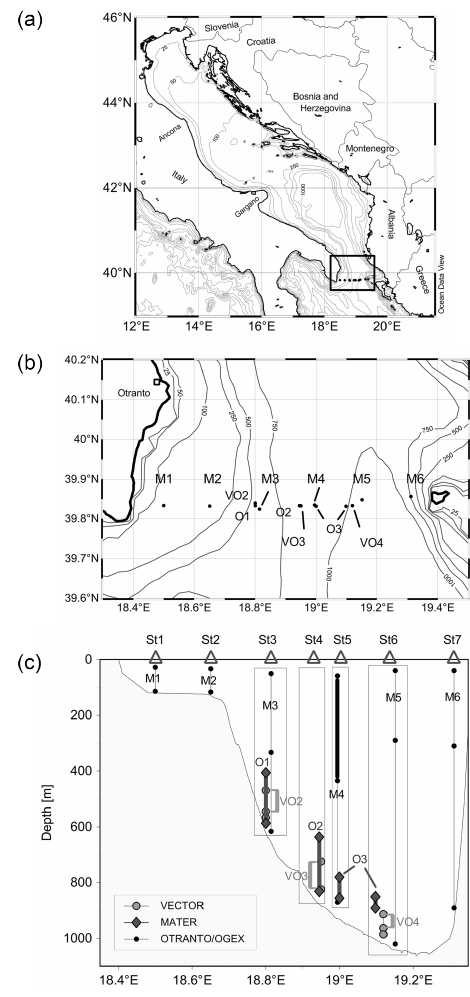
Fig. 1. (a) Study area in the Strait of Otranto at the southern end of the Adriatic Sea, depicted by a rectangle and expanded in (b) . (b) Mooring locations with original station nomenclature. Sea level and wind are available at the coast in Otranto. (c) Vertical scheme of the mooring lines: thick lines indicate layers covered by ADCPs. Both the original station nomenclature and the one adopted in this paper (St1, ..., St7) are indicated. St3, St4, St5 and St6 enclose 2 or 3 moorings within dashed-line rectangles. Current measurements were conducted within the framework of different projects (see leg- end) during the time interval 1994–2007. Depth contours in (a) and (b) are in